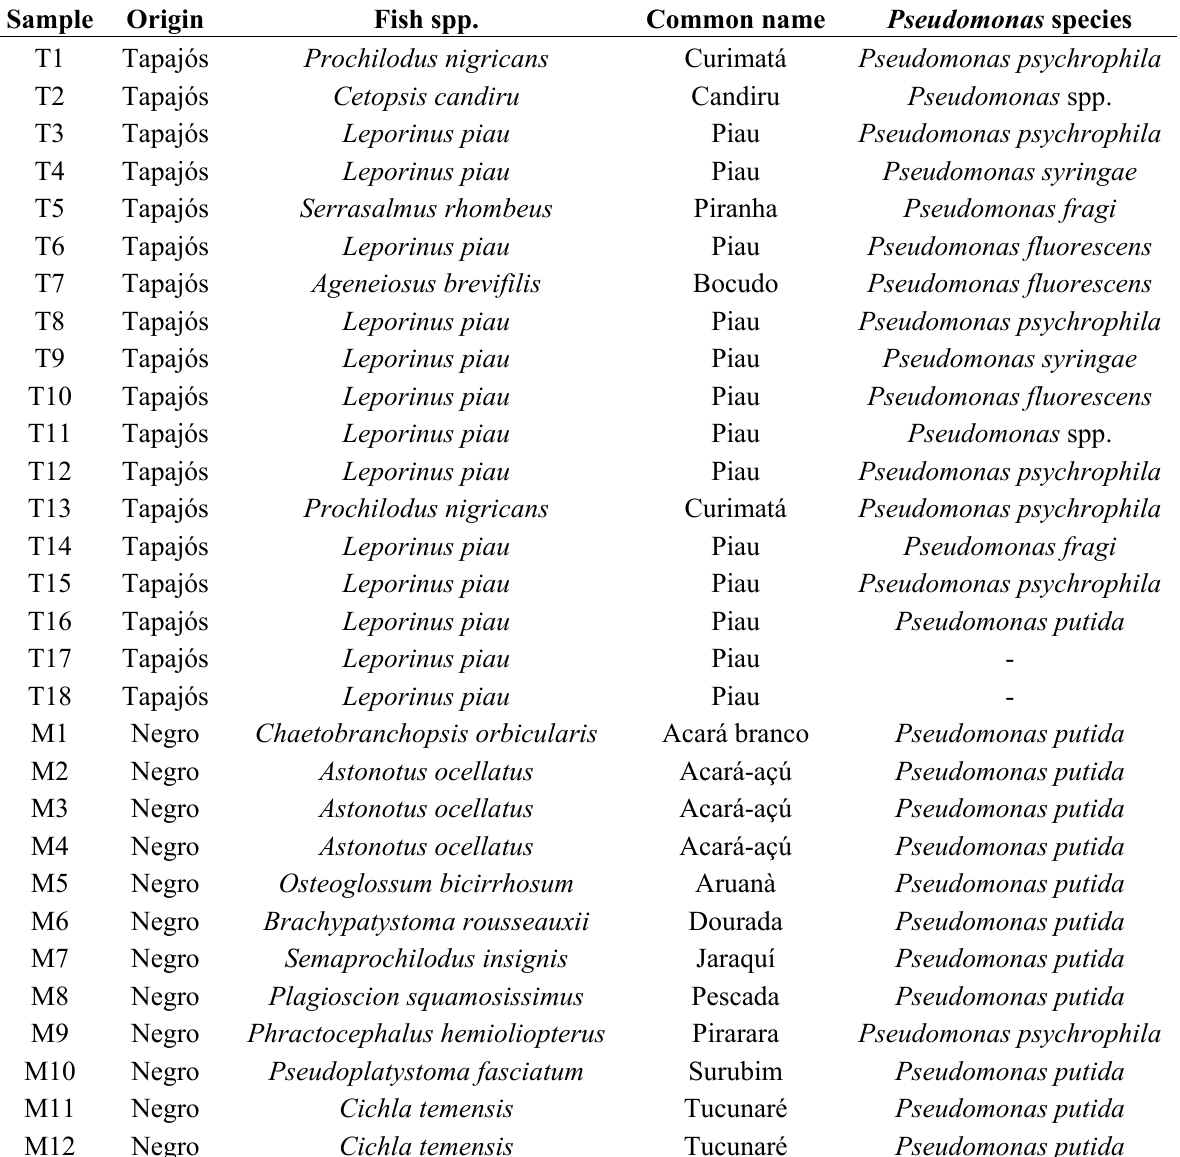
Table 1. Samples analyzed, fish species with their common names and Pseudomonas species